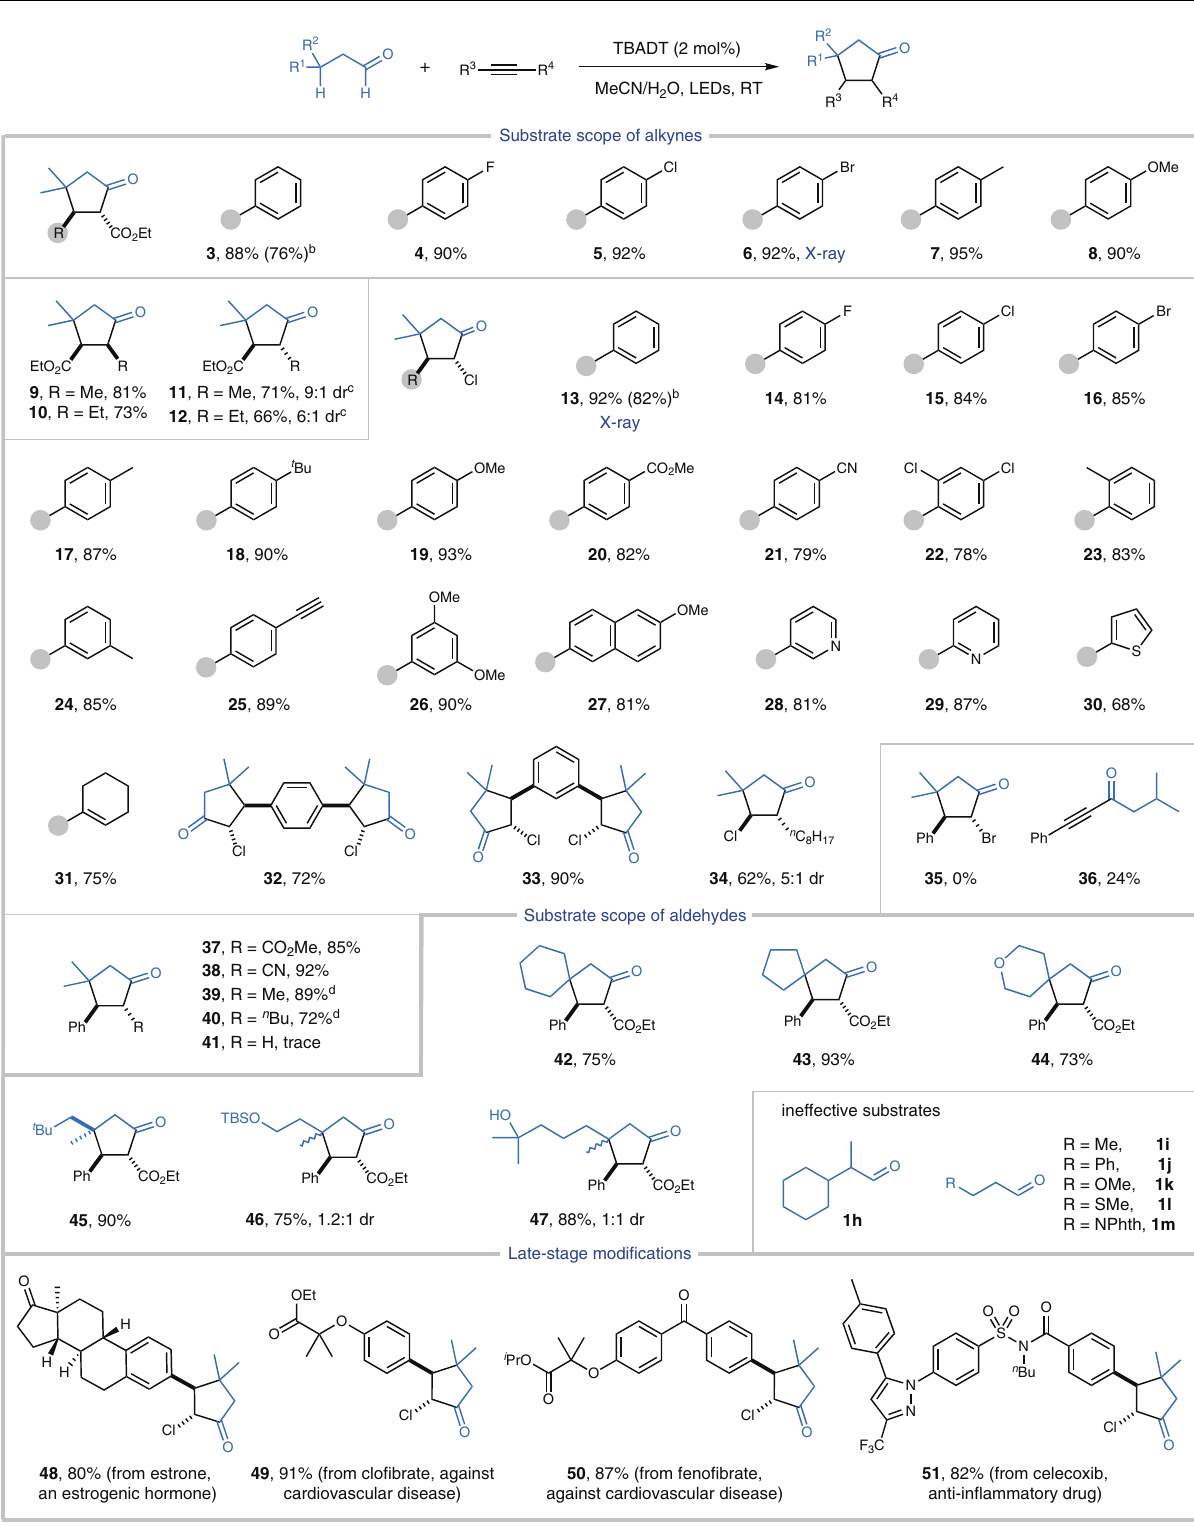
Fig. 2 | Scope of the reaction. Reaction conditions: see Table 1, entry 1; Isolated yields are given. Unless otherwise noted, the desired products were obtained with ≥ 10:1 dr selectivity. b Yield of 1.0mmol scale. c (i) see Table 1, entry 1; (ii) NaOH